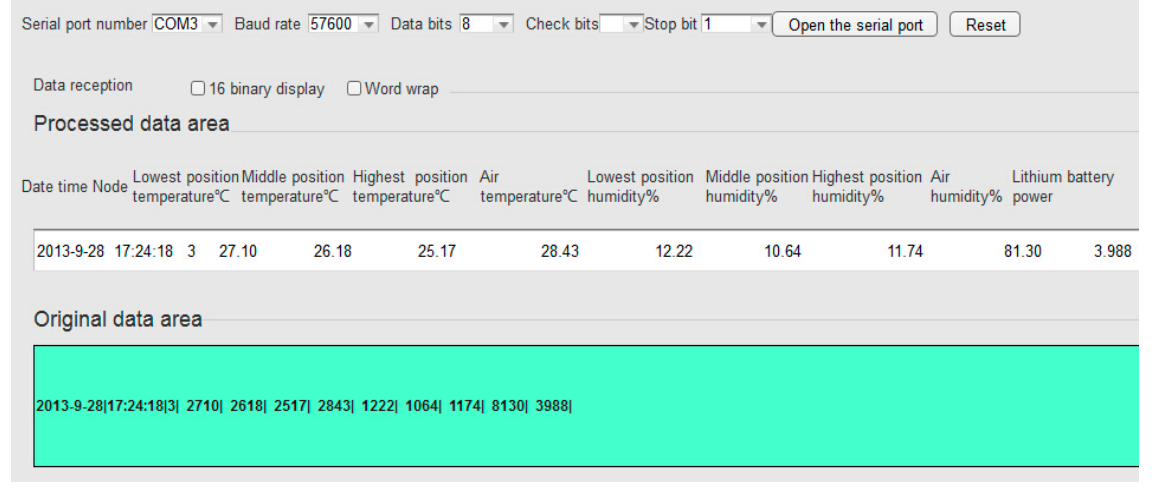
Figure 7. Remote server monitoring interface.